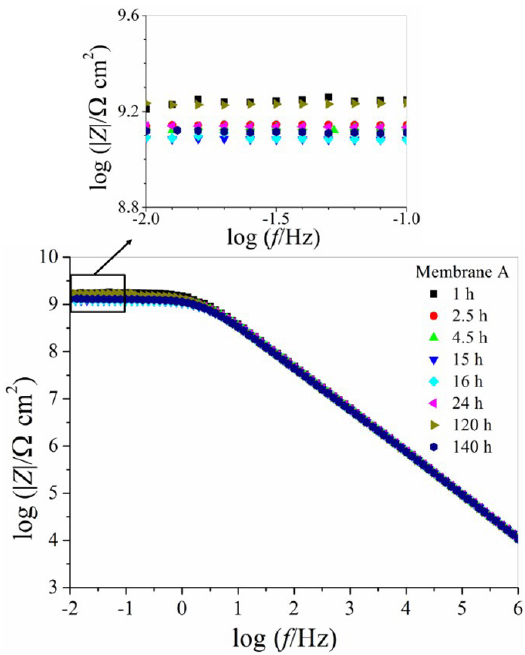
Figure 6. Impedance modulus |Z| Bode plots for the membrane A obtained in 0.1 mol/L KCl, with 100 mV (rms) amplitude in a permeation